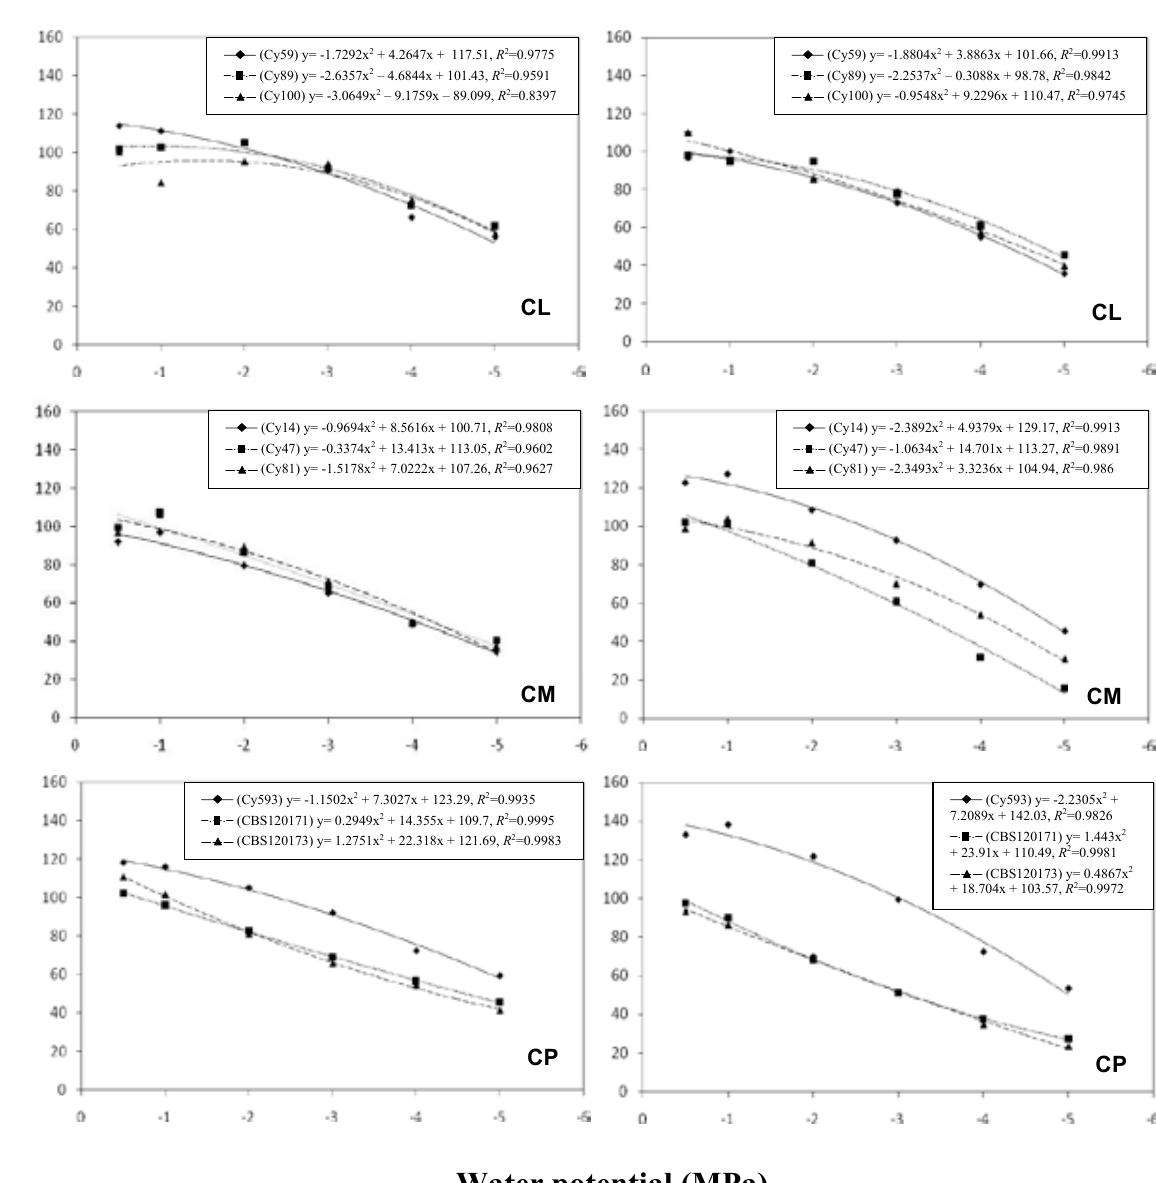
Figure 3. Mean relative colony radial growth (as a percentage of that on nonamended media) of three isolates of C. lirioden- dri (CL) , C. macrodidymum (CM) and C. pauciseptatum (CP), after 10 days of incubation in darkness at 25ºC on PDA amended with KCl or NaCl to give the following water potentials -0.5, -1, -2, -3, -4 or -5 MPa . The water potential of nonamended PDA was -0.3MPa. Data points are the means of two independent sets of four pseudoreplicates in each experiment. Vertical bars are the standard error of the